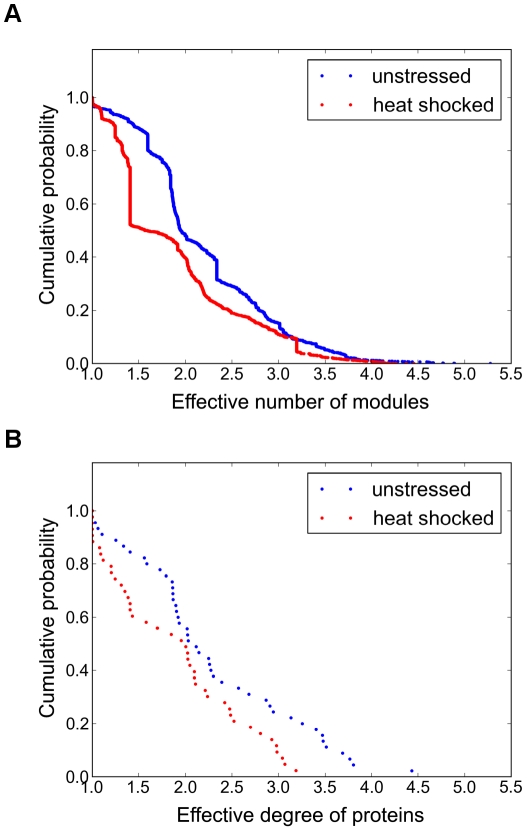
Heat shock induces a partial decoupling of the modules of the yeast interactome.Unstressed and heat shocked (15 min heat shock at 37°C) yeast BioGRID protein-protein interaction networks were created as described in the Materials and Methods section. Overlapping modules were calculated by the NodeLand influence function method combined with the ProportionalHill module membership assignment method [8] as described in Materials and Methods. Panel A. Overlap of yeast interactome modules in unstressed condition (blue dots) and upon heat shock (red dots). The overlap of yeast interaction modules was represented by the cumulative distribution of the effective number of modules of yeast proteins (for the detailed explanation of the meaning of ‘effective number’ describing a weighted sum of modules, see Materials and Methods). Upon heat shock the number of modules, that a yeast protein simultaneously belongs to, was significantly decreased (significance for the distribution by the Wilcoxon paired test, p<2.2*10−16). In other words this means that there were smaller overlaps between the interactome modules. Panel B. Cumulative distribution of the degree of yeast interactome modules in unstressed condition (blue dots) and upon heat shock (red dots). The effective degree of modules was calculated as described in Materials and Methods. Upon heat shock the cumulative distribution of effective degree of modules was significantly decreased (Mann-Whitney U test, p = 0.02299), which means that the protein-protein interaction network modules were less connected in heat shock than in the unstressed state.